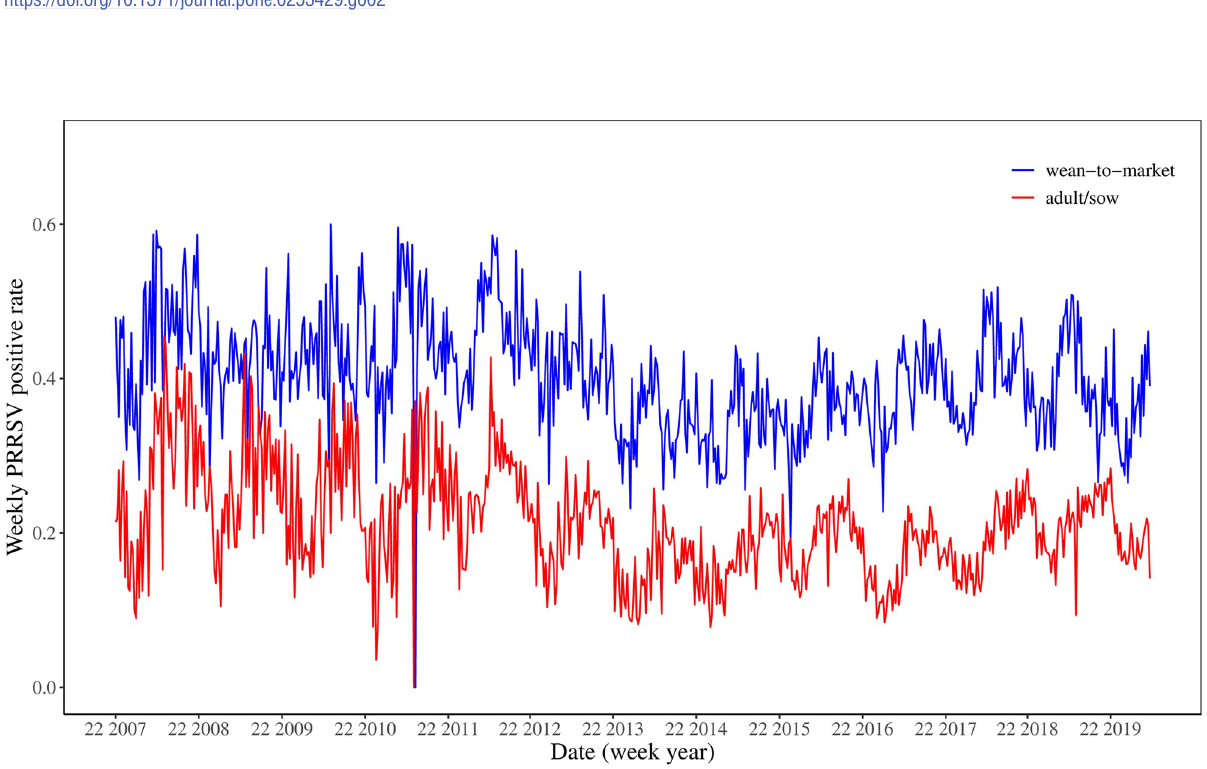
Fig 3. Weekly porcine reproductive and respiratory syndrome virus (PRRSV) positive rate time series by age categories from 2007 to 2019. The data begins on the 22nd week (i.e., the first week in June) in 2007.